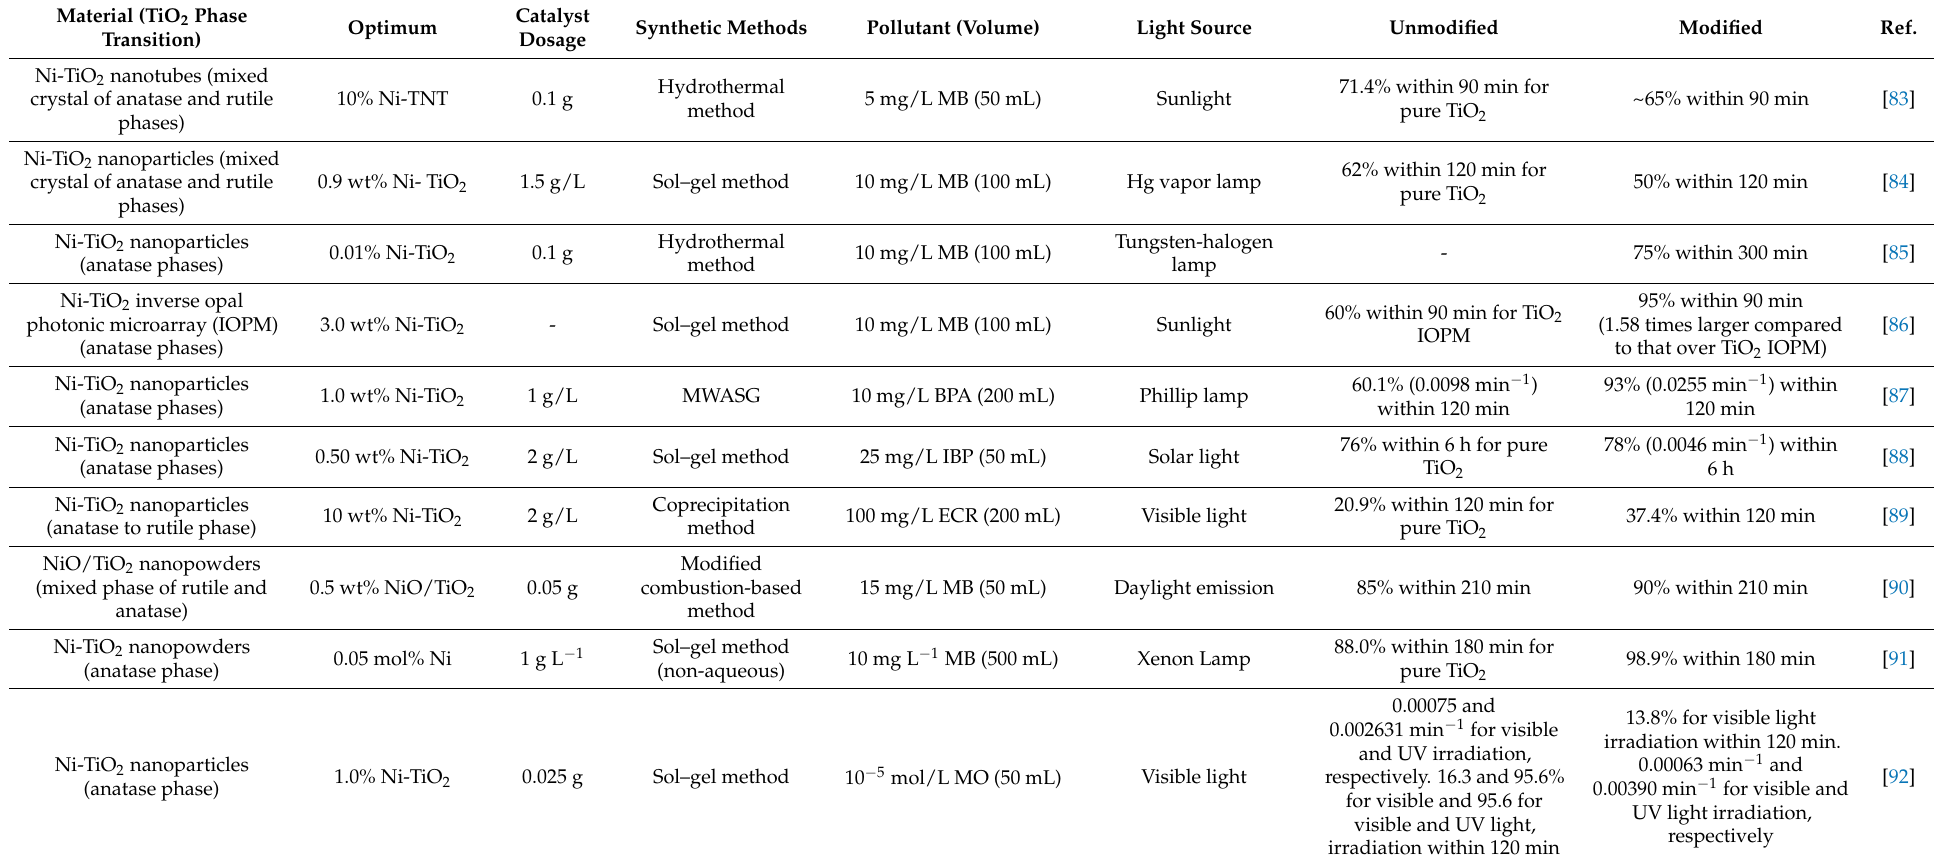
Table 4. Summary of recent progress on Ni-TiO 2 photocatalysts for organic pollutants